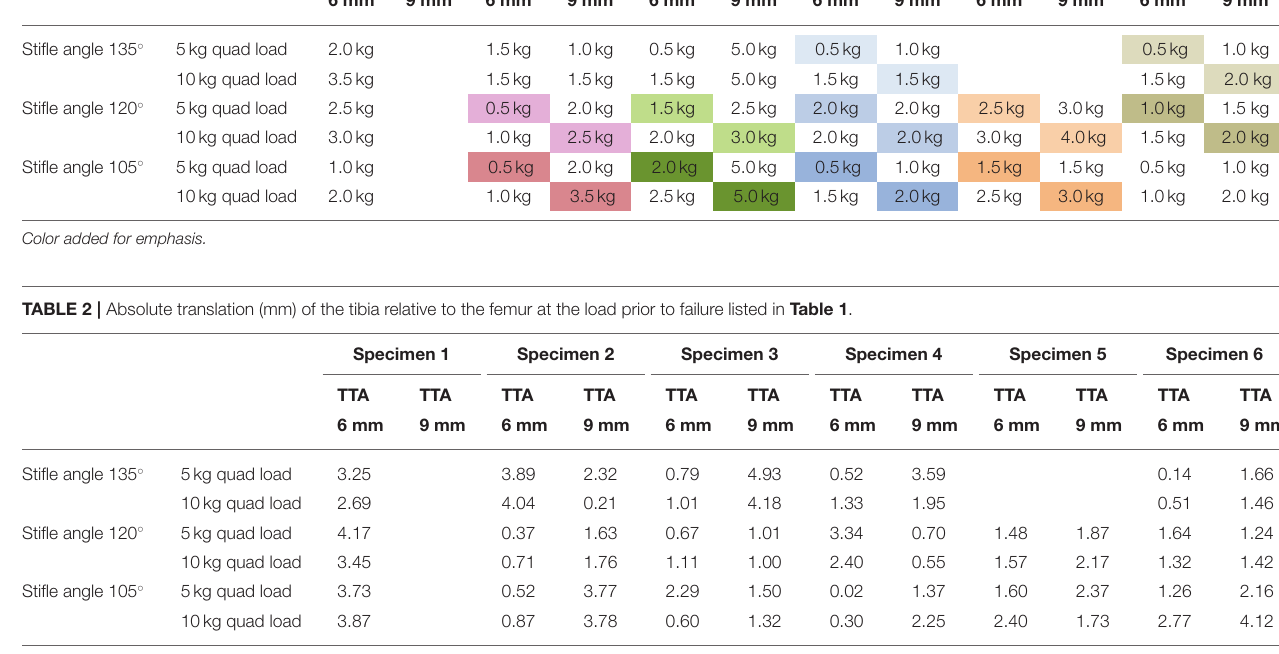
TABLE 1C | The change in the pes load prior to failure with increasing tibial tuberosity advancement and quadriceps load.